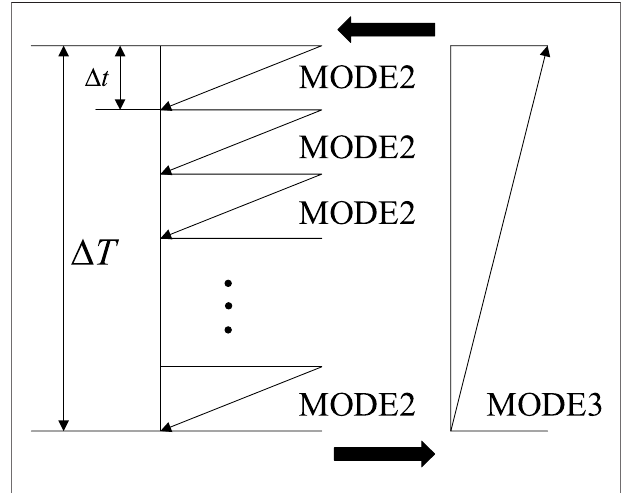
FIGURE 7 | Realization mechanism of modeling with multiple time scales.